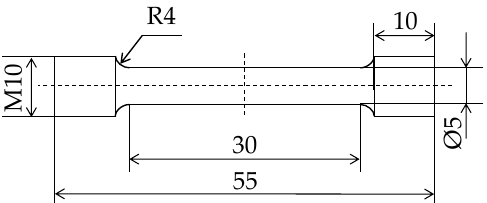
Figure 3. Shape and dimensions of the tensile sample (mm).